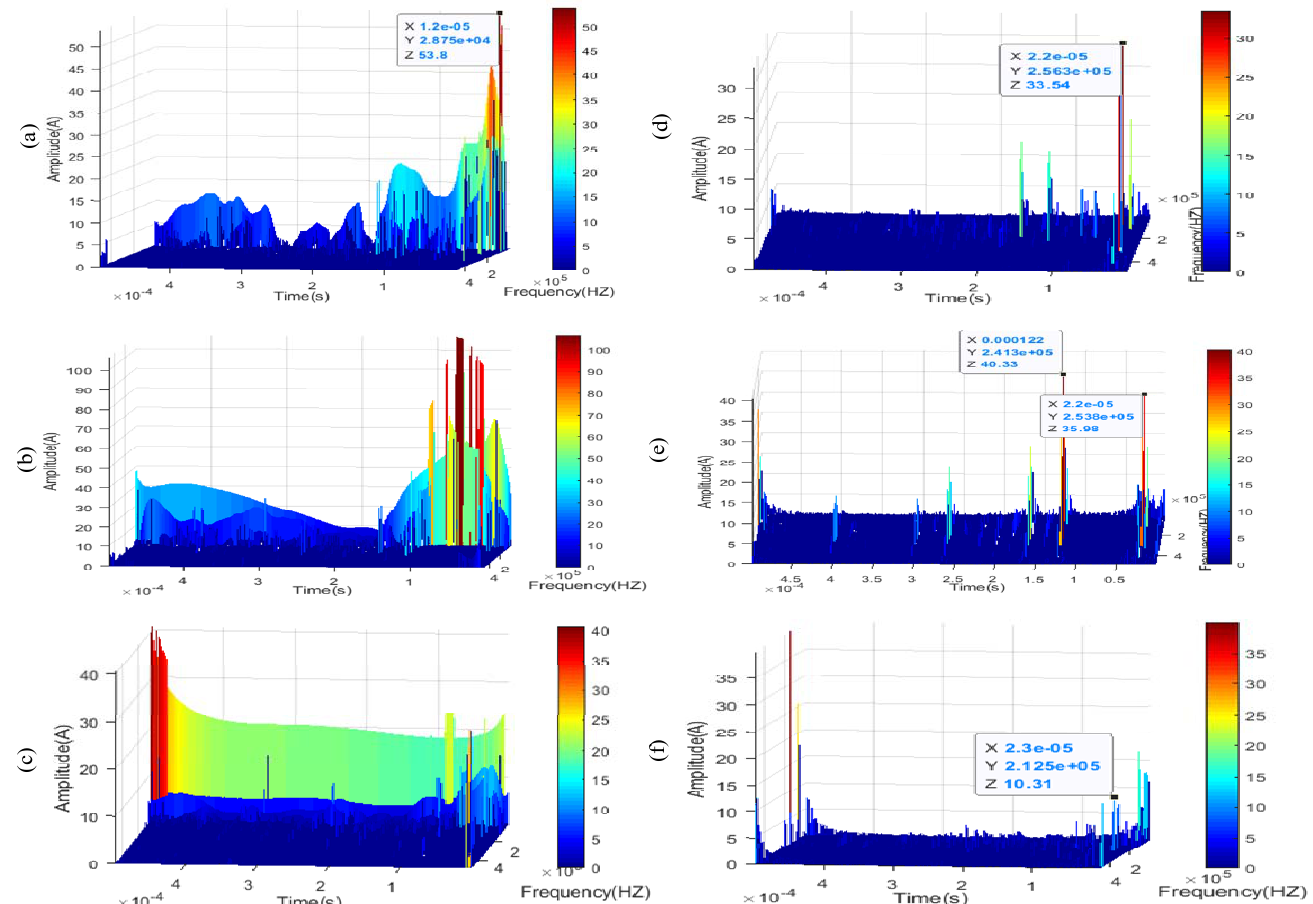
Figure 15. Time frequency energy diagram of short circuit fault before and after improved HHT.